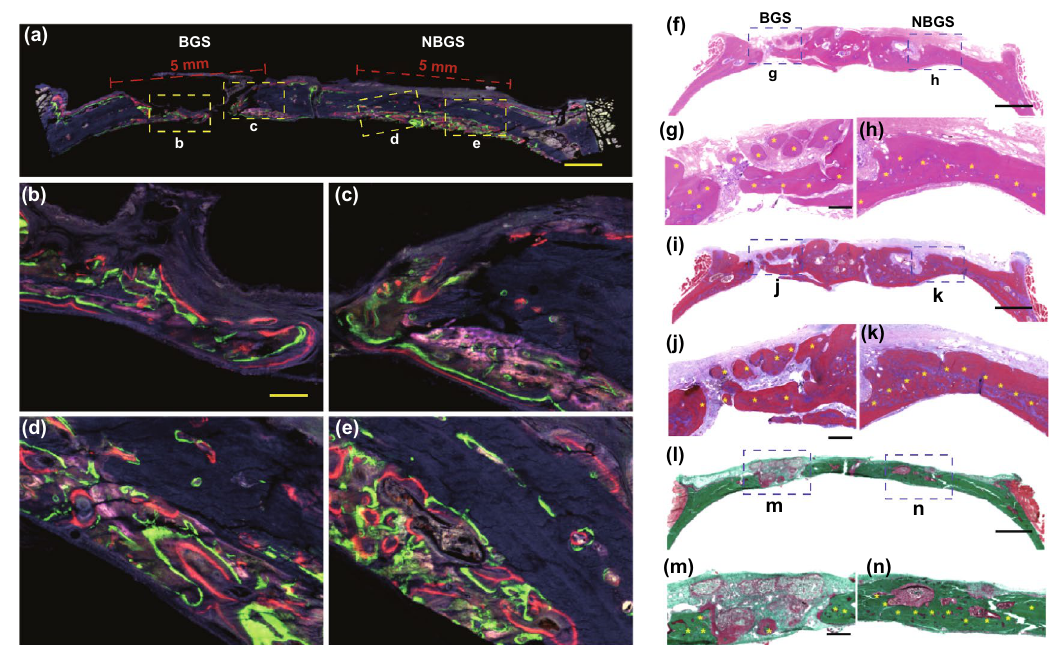
Fig. 6 Fluorescent imaging and histological staining of the cranial bone defect to assess newborn osseous tissue. a Tetracycline hydrochloride (blue fluorescence), calcein AM (green fluorescence) and alizarin red (red fluorescence) (scale bar, 1 cm) were injected subcutaneously into rats with calvarial defect at week 2, 4 and 6, and different colors of fluorescence represent newborn bone tissue in different durations. Representative newborn bone induced by BGS b , c and NBGS d , e showing the new woven bone around the scaffold at week 8 (scale bar, 250 μm). f – h H&E staining, i – k Masson trichrome staining and l - n Goldner trichrome staining of the cranial defect implanted with BGS/NBGS at week 24. The scale bar equals 2 mm ( f , i , l ) and 200 μm ( g , h , j , k , m , n ). (Color figure